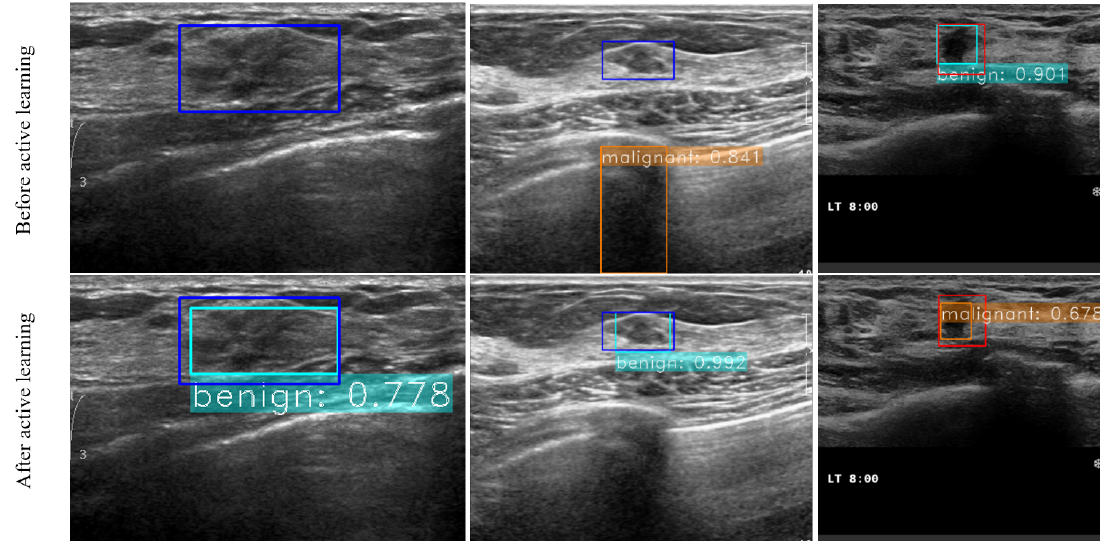
Figure 5. Qualitative results for controlling α . Bounding boxes colored red/blue are ground truth boxes for malignant/benign masses. Bounding boxes colored orange/cyan are predictions for malignant/benign masses. Boxes on the left are the results before active learning, and the right side shows the same predictions made for the images after active